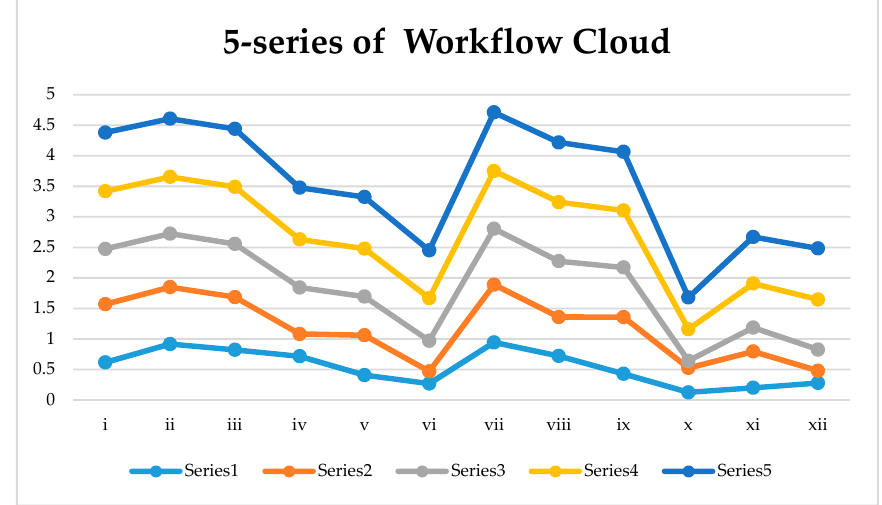
Figure 4. 5-series of workflow comparative studies of existed algorithms.